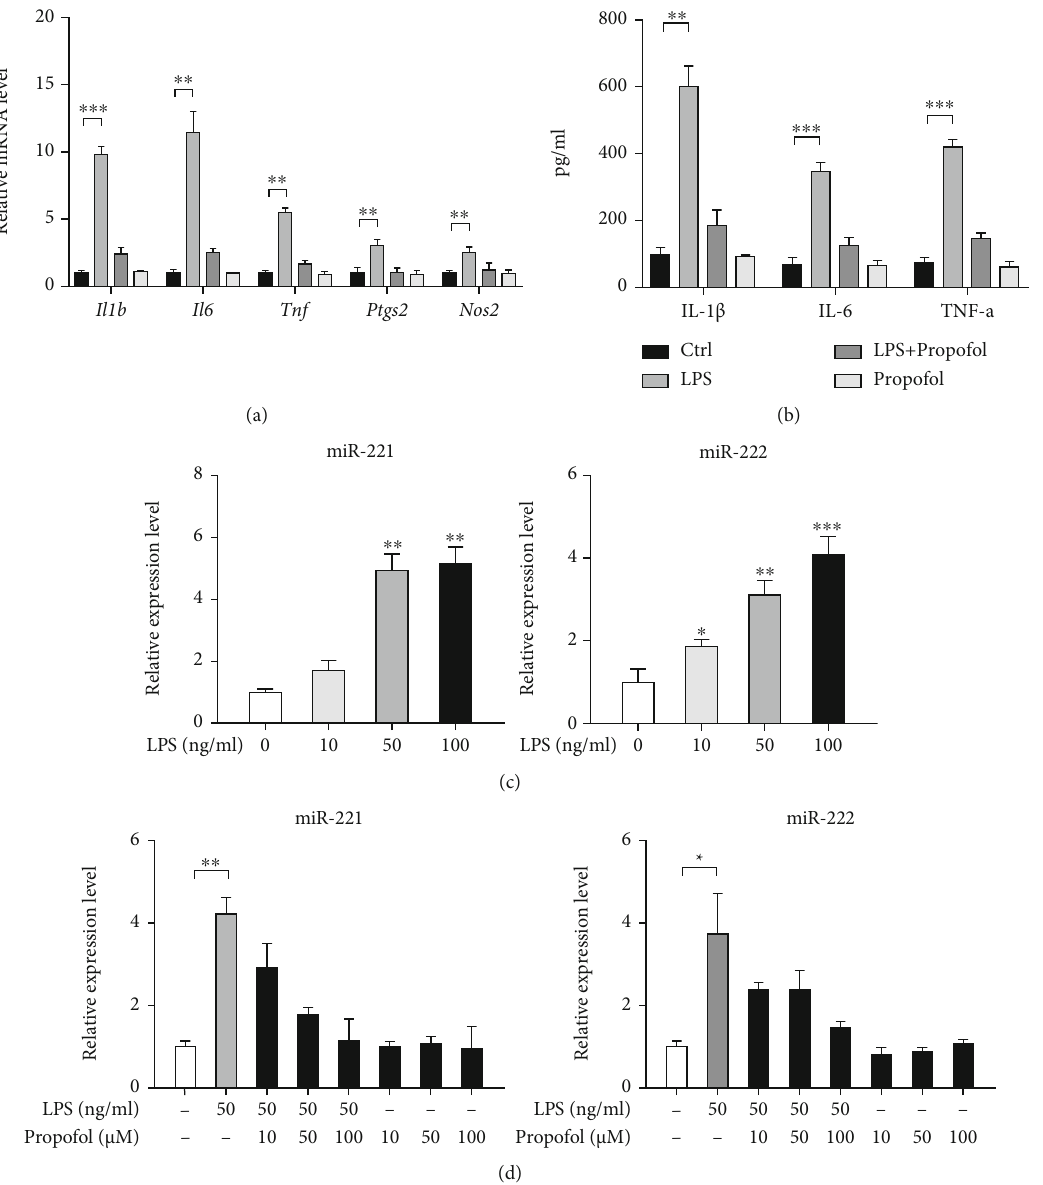
Figure 1: Expression of miR-221/222 is downregulated by propofol. (a) The inhibitory e ff ects of propofol on the mRNA expression of in fl ammatory genes ( Il1b , IL6 , Tnf , Ptgs2 , and Nos2 ) in LPS-primed BV2 cells were determined by real-time qPCR analysis ( n = 3 ). (b) The inhibitory e ff ects of propofol on the level of in fl ammatory cytokines (IL-1 β , IL-6, and TNF- α ) in conditioned medium from LPS- primed BV2 cells were analyzed by ELISA ( n = 3 ). (c) miR-221 and miR-222 expression in BV2 cells upon treatment with di ff erent concentrations of LPS were analyzed by real-time qPCR ( n = 3 ); comparisons were done with 0ng/ml LPS. (d) miR-221 and miR-222 expression in LPS-primed BV2 cells upon treatment with di ff erent concentrations of propofol were analyzed by real-time qPCR ( n = 3 ). ∗ p < 0 : 05 , ∗∗ p < 0 : 01 , and ∗∗∗ p < 0 : 001